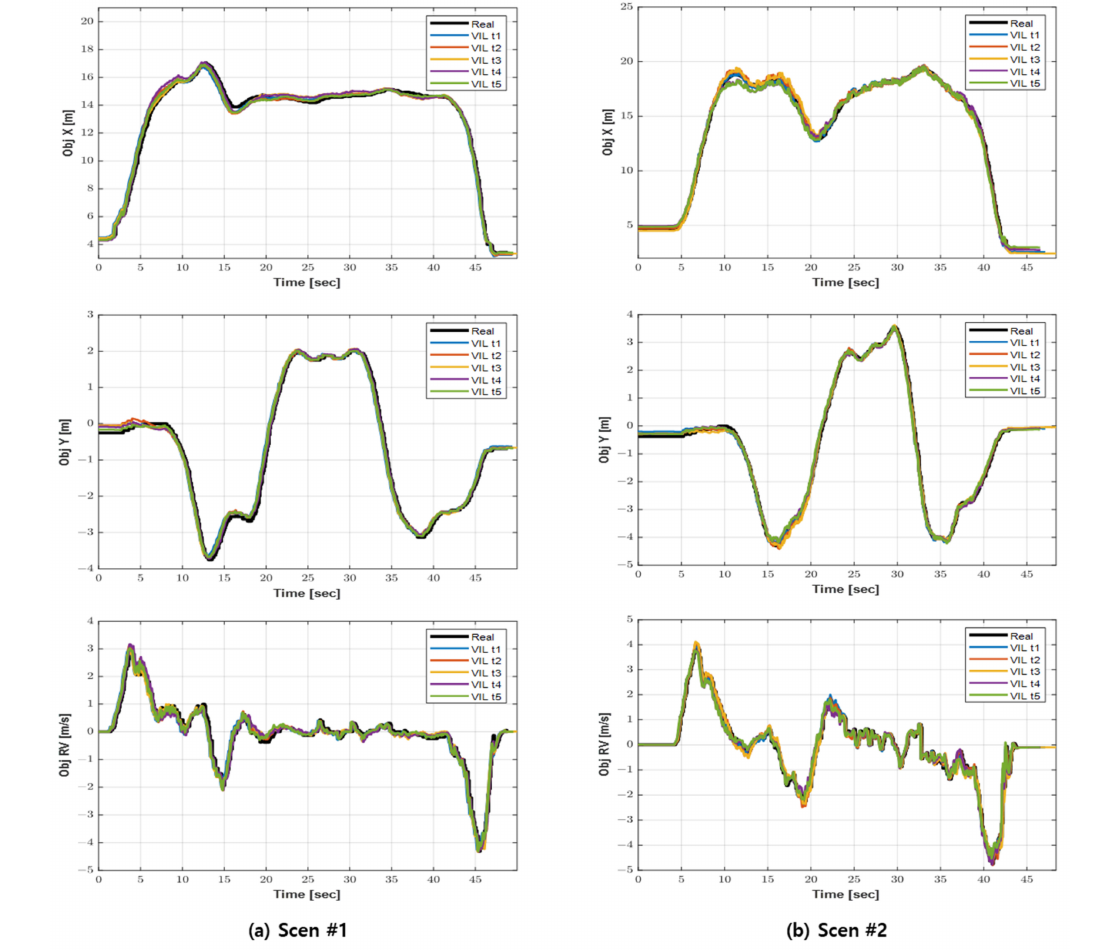
Figure 17. Result of sensor data